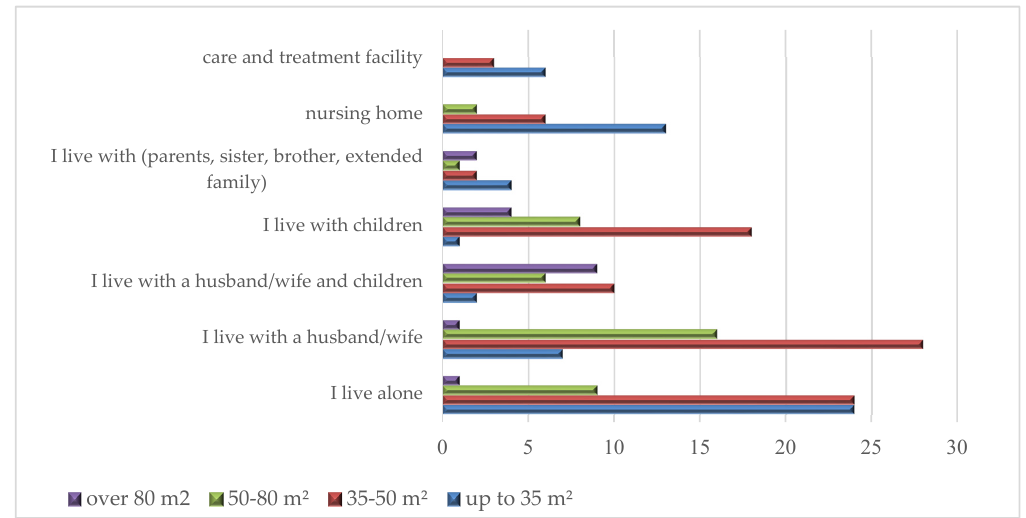
Figure 8. Square footage of an apartment at a senior housing estate by family situation preferred by the respondents (number of indications).